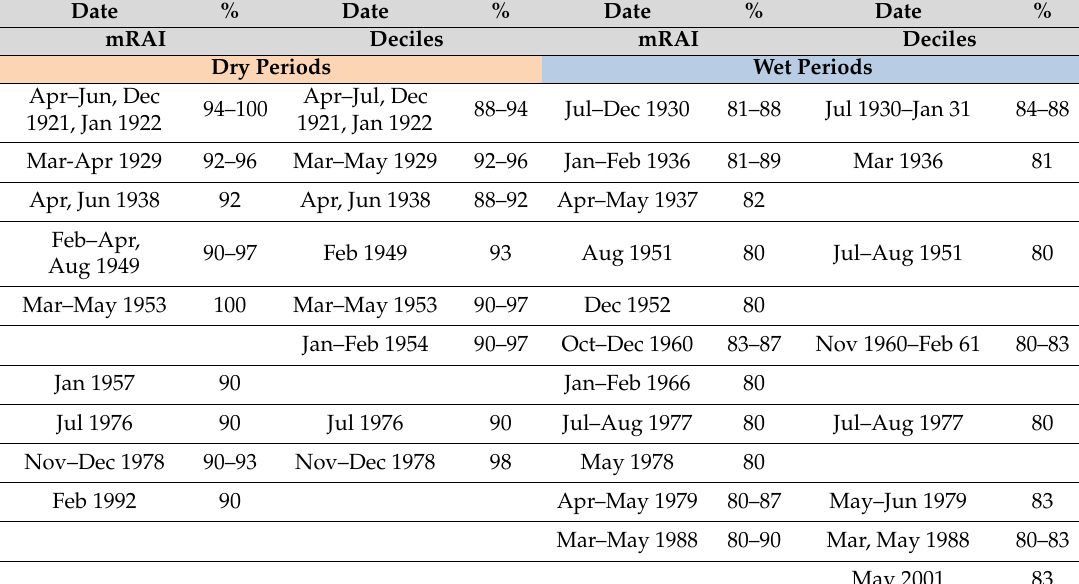
Table A5. Sub-region Western Europe—overview on the TOP20 months with the highest spatial extent of dry and wet periods within the study period 1921–2015.